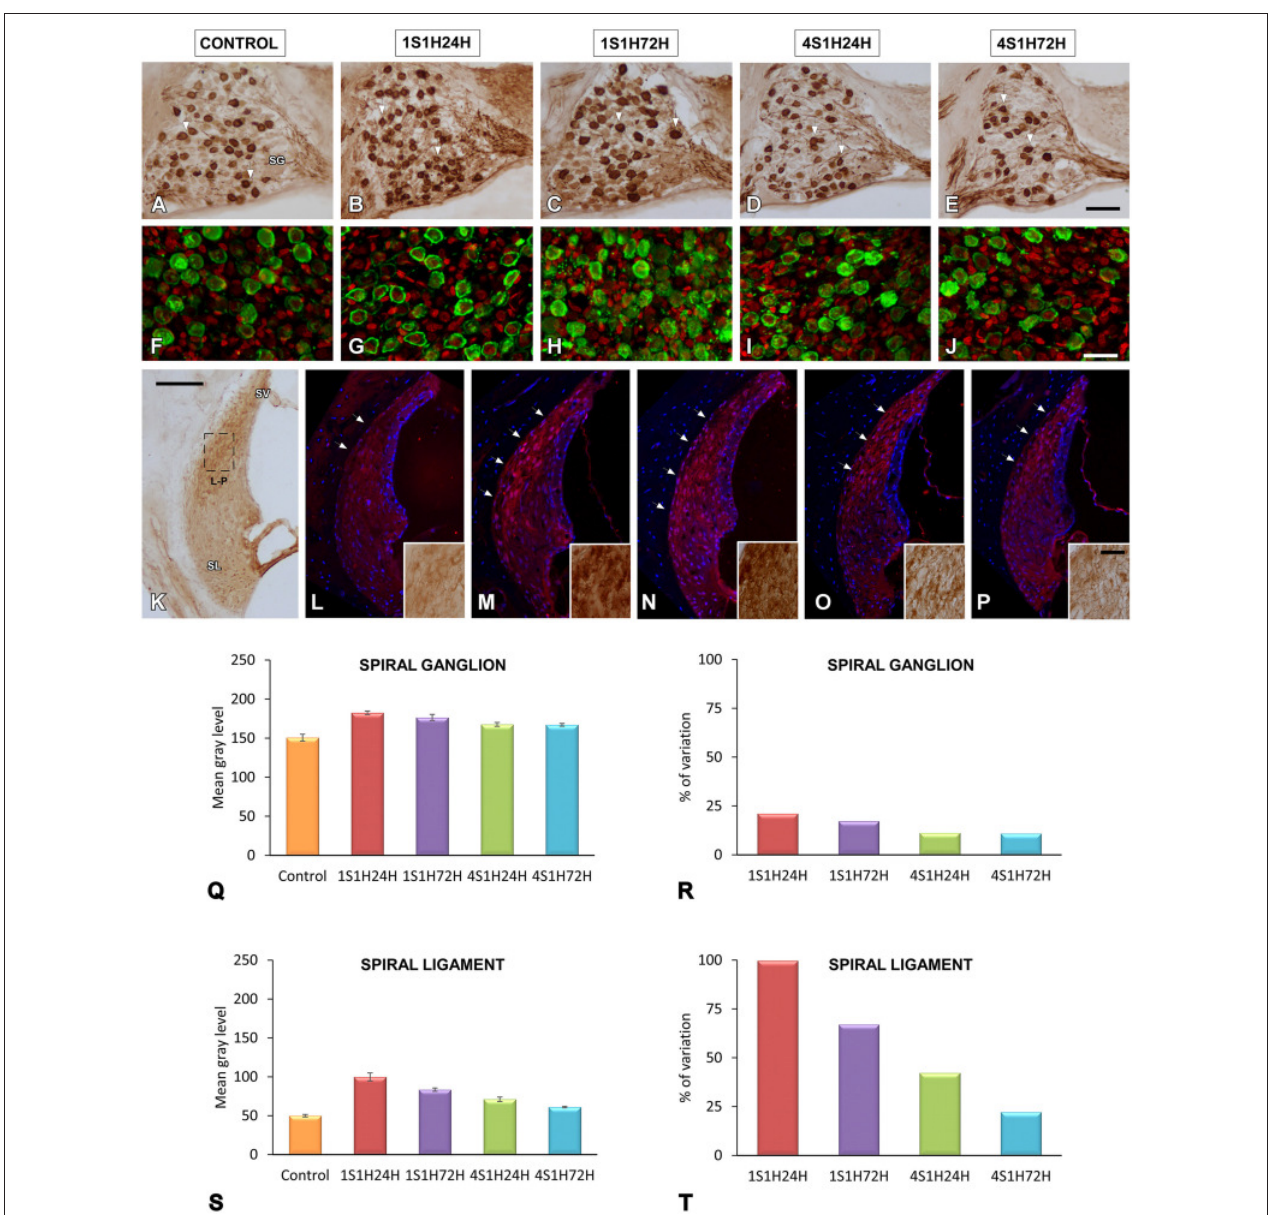
FIGURE 6 | Digitized images illustrating CR immunoreactivity in the spiral ganglion (A–J) and the spiral ligament (K–P) in control and experimental Wistar rats. Before noise overstimulation, CR immunostaining in the spiral ganglion was characterized by dark immunopositive somata and fibers that were lightly stained throughout the ganglion (A,F) . Meanwhile, in the spiral ligament, the staining was present in type I fibrocytes that were moderately stained and distributed in the dorsolateral area (arrows and inset in L ). Following the noise-induced toughening protocol, there was an increase in the immunostaining in spiral ganglion neurons and neuropil in 1S1H24H (B,G) rats that was still present at 1S1H72H (C,H) , 4S1H24H (D,I) , and 4S1H72H (E,J) animals relative to the control condition. Similar increases were also observed in the spiral ligament (arrows and inset in M–P ) when compared to the control condition (arrows and inset in K,L ). Bar graphs indicate the mean gray levels of CR immunostaining and its corresponding percentage of variation in the spiral ganglion (Q,R) and spiral ligament (S,T) in experimental and control rats. The square box in (K) indicates the approximate location of the high-magnification images illustrated in (L–P) . Scale bars represent 100 µ m in (K) , 50 µ m in (E), and 25 µ m in (J,P) . SG, spiral ganglion; SL, spiral ligament; SV, stria